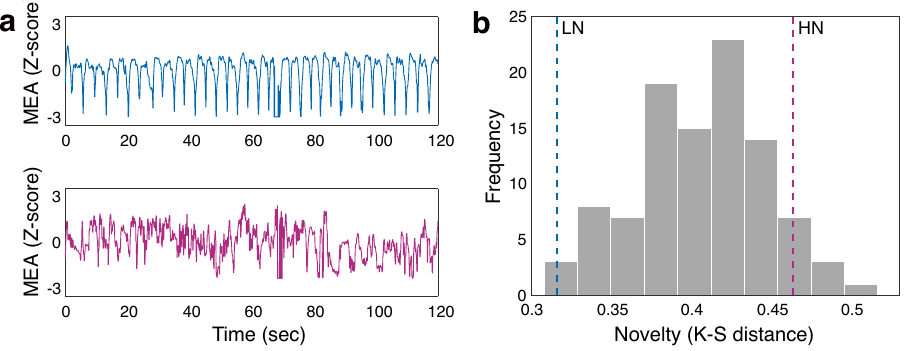
Figure 2. The dyads moved in a novel manner. ( a ) The upper panel shows the Z-scored MEA of repetitive up and down hand movements—low-novelty (LN) movement. The bottom panel shows the Z-scored MEA of diverse and novel hand movements—high-novelty (HN) movement. The hand movements were measured in a setup identical to that of the dyadic Mirror Games. ( b ) A histogram of the novelty of the dyads’ movements during the Mirror Game. The blue dashed line denotes repetitive hand movements up and down (LN). The magenta dashed line denotes diverse and novel movements